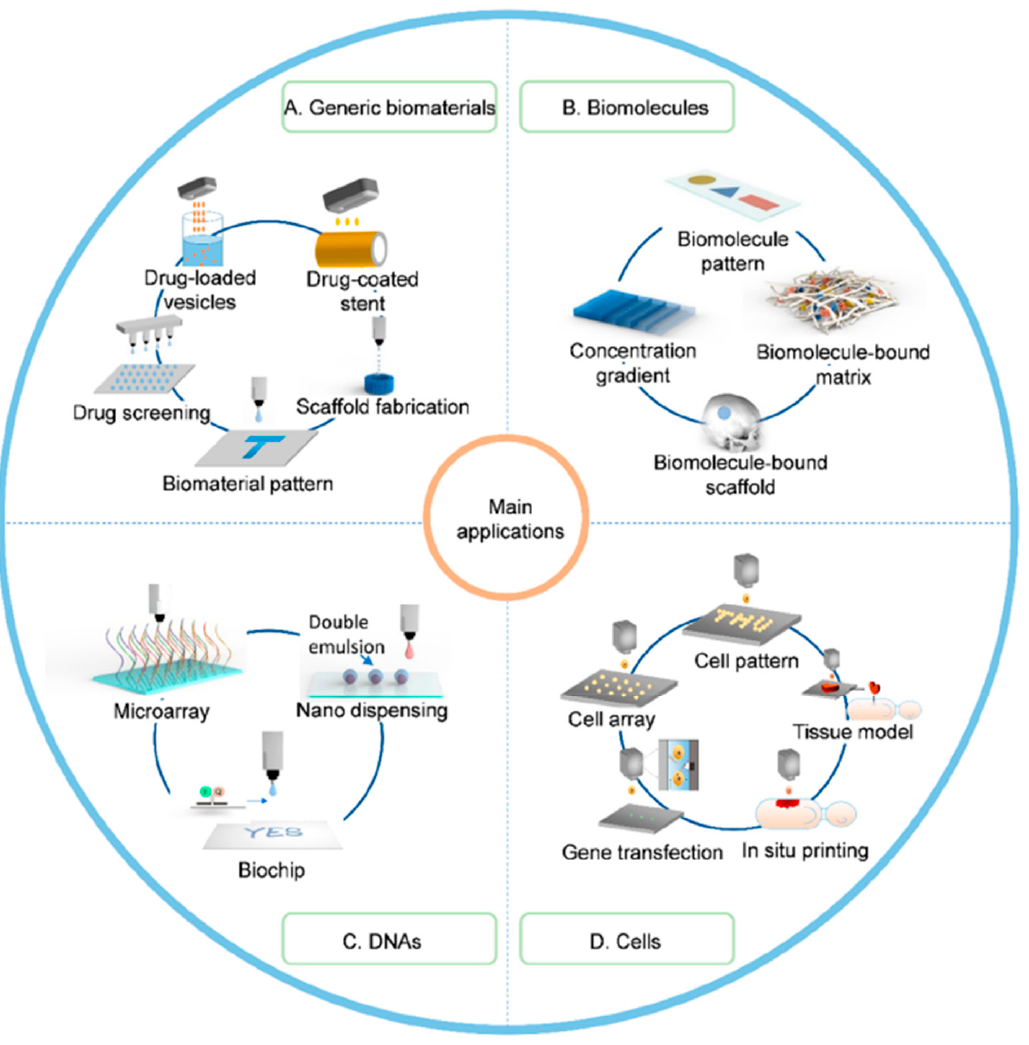
Figure 8. Schematic illustration of major applications of inkjet bioprinting. ( A ) Generic biomaterials were printed for pharmaceutical applications including drug screening, drug loading and drug coating and for biomaterial patterning and scaffold fabrication. ( B ) Biomolecules were printed for concentration gradient, biomolecule pattern, biomolecule-bound matrix and biomolecule-bound scaffold. ( C ) DNAs were printed for microarray, nano-dispensing and biochip. ( D ) Cells were printed for cell array, cell pattern, tissue model, in situ printing and gene transfection [89].